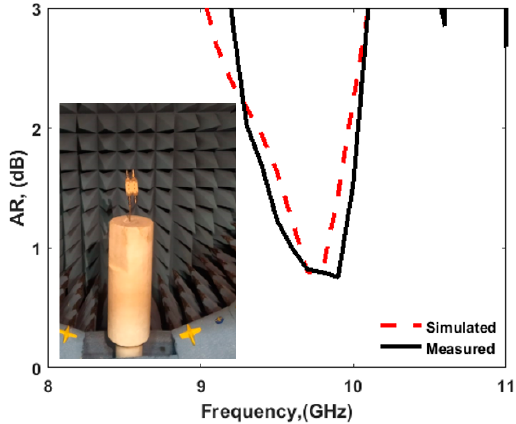
( b ) Figure 12. Measured and simulated ( a ) reflection and ( b ) isolation response for 4-port MIMO con- figuration. The mismatching between the two results was due to fabrication tolerances, but it was still at a good level. The advantage of the proposed CP MIMO DRA is that it provides the CP response at all individual ports. Figure 14 illustrates the simulated 3D patterns of the MIMO DRA at each port at 9 and 11 GHz. As the antenna operated with the funda- mental mode, the broadside radiation was obtained. Figure 15 shows the simulated RHCP and left-hand (LH) CP field pattern at the frequency where the dip of AR was obtained. The antenna provided the dominant LHCP by around 18 dB over the cross-polarized com-